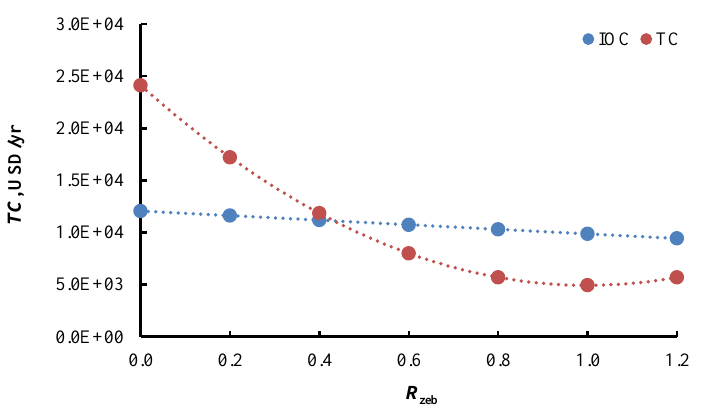
Fig. 6. The total cost of the community under ZEC level